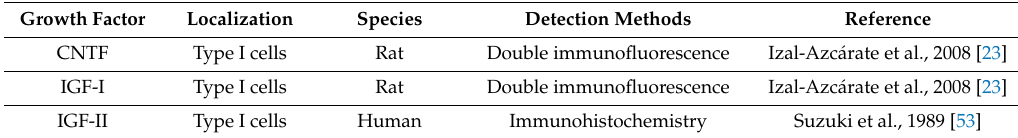
Table 5. Ciliary neurotrophic factor family and insulin-like growth factor family. Expression of CNTF, IGF-I, and IGF-II in the carotid